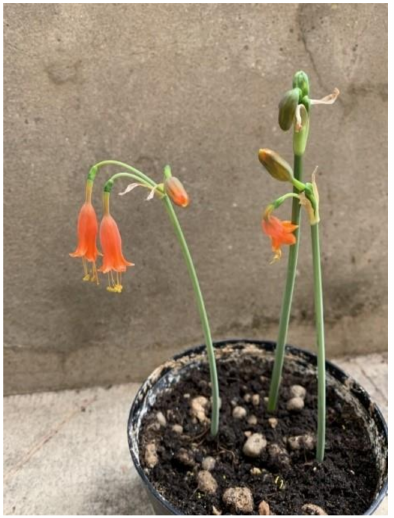
Figure 1. Urceolina peruviana